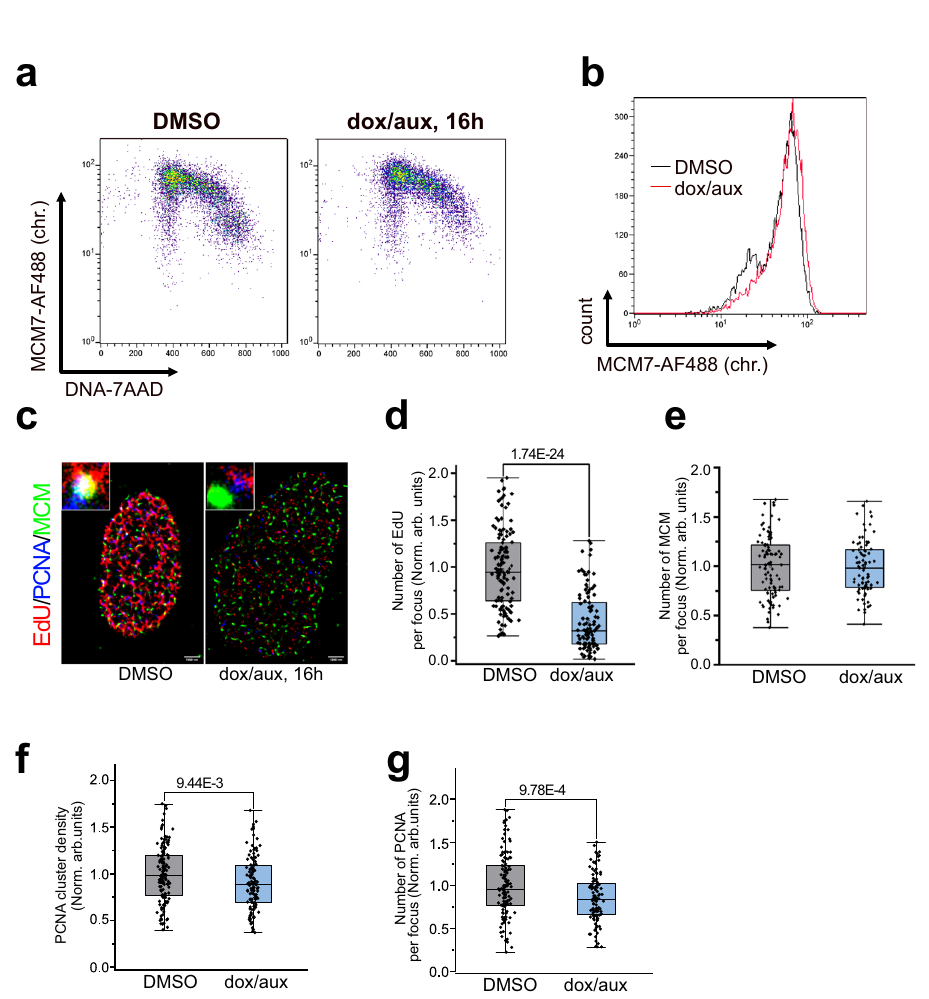
Fig.4|MCMonchromatinafterPOLE1depletion.a , b Clone16cellsweretreated for 16h with DMSO or dox/aux, followed chromatin extraction and MCM7 immu- nostaining. Flow cytometry plots of DNA/MCM7 staining ( a ) or MCM7 histograms ( b )areshown. c – g Clone16cellstreatedfor16hwithDMSOordox/auxwerepulse labeled with thymidine analog EdU for 15min prior to processing for super- resolutionimaging.Representativemulticolorsuper-resolutionimages( c )ofPCNA (blue),MCM(green),andextentofEdU(red)incorporationinS-phasenuclei.Scale bar, 1500nm. QuantitationofEdU( d )and MCM( e )detected perfocus normalized